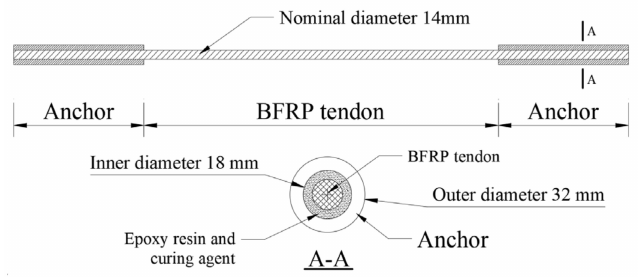
Figure 1. Configuration of the BFRP tendon with bonded